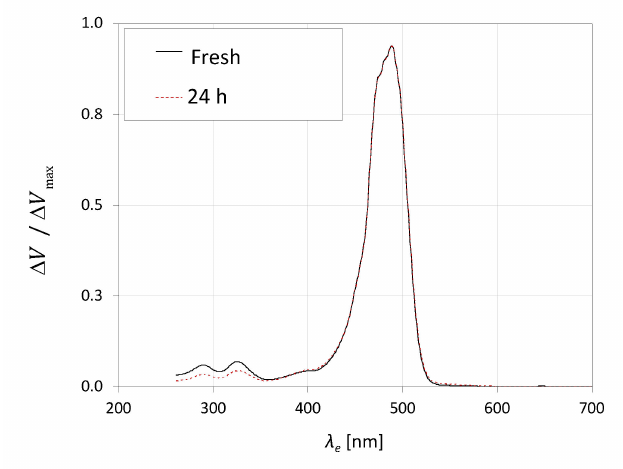
Figure 5. Electric potential difference associated with fluorescein versus the excitation wavelength for 20 mg · L − 1 solution in H 3 PO 4 0.100 M + NaOH 0.165 M medium, immediately after preparation and 24 h